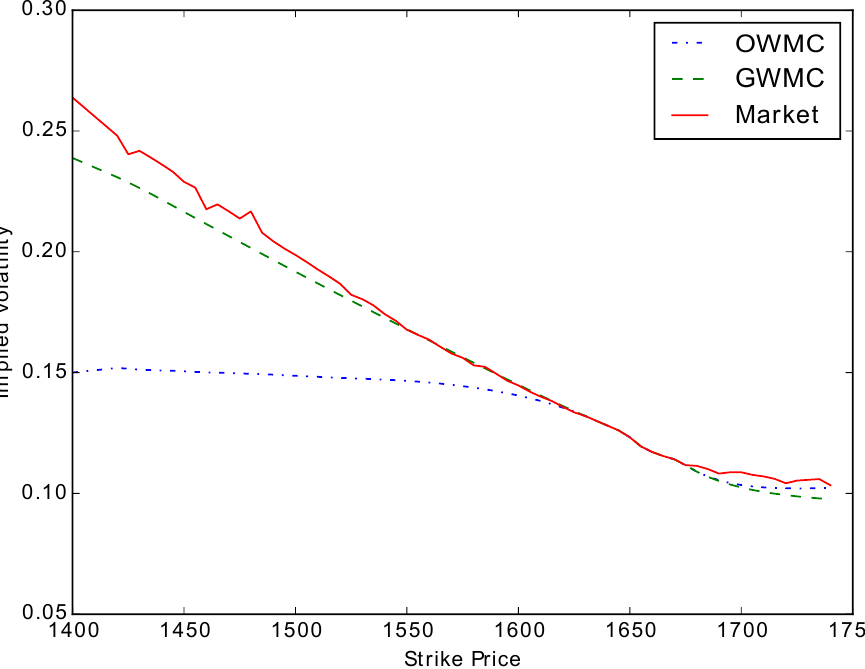
Figure 4. The volatility for SPX options with maturity 30 days implied by market prices, the OWMC calibrated GBM model, and the GWMC calibrated GBM model.